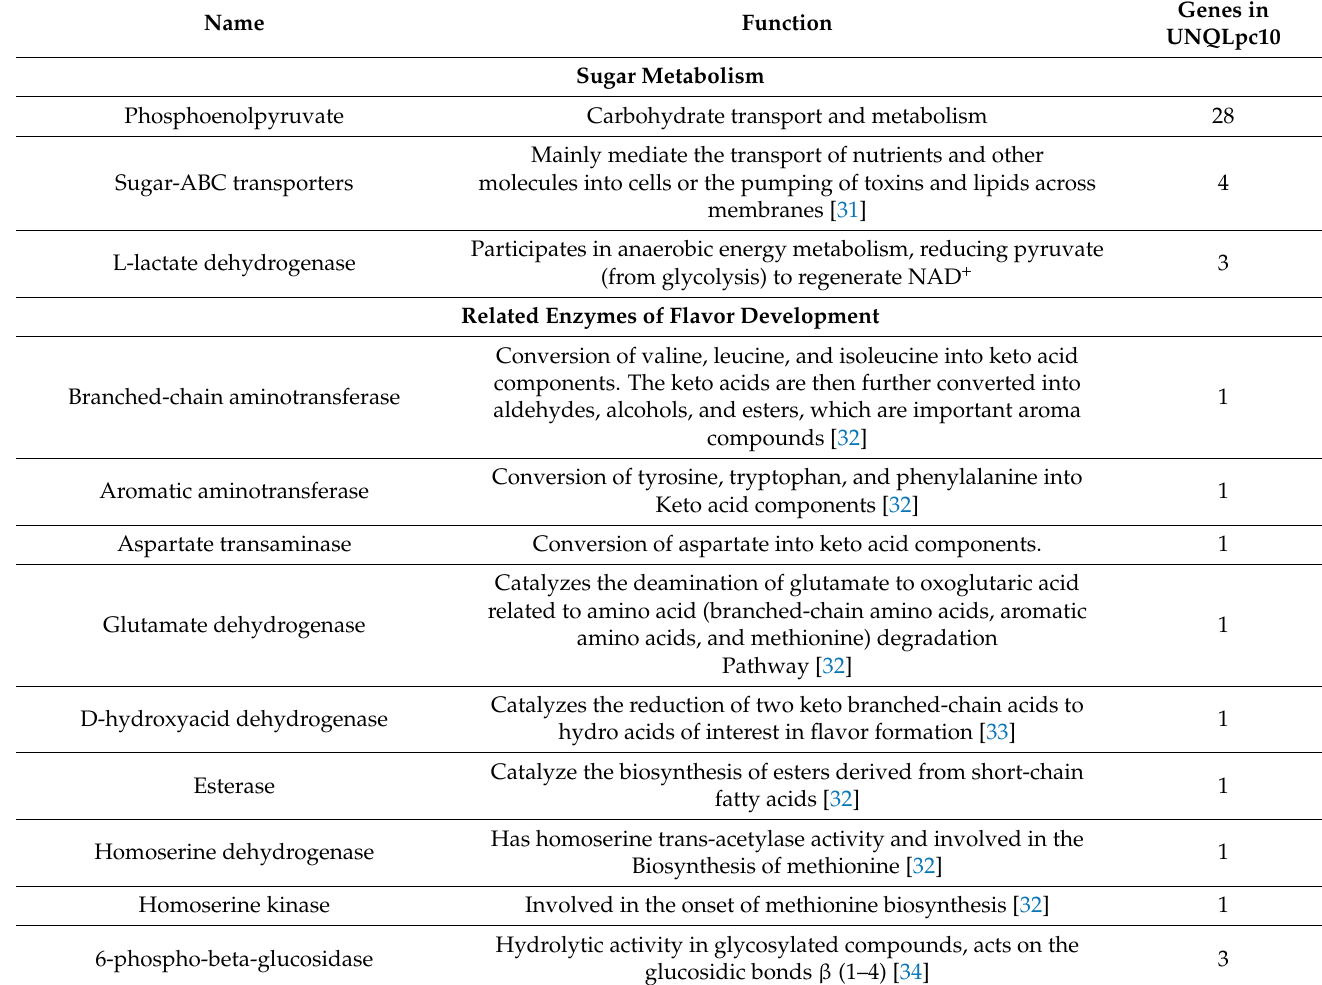
Table 1. In silico analysis of the UNQLpc 10 genome looking for genes coding for enzymes of technological